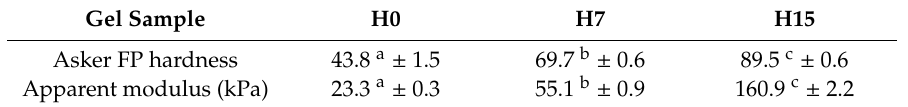
Table 3. Characteristics of urethane gels used as artificial